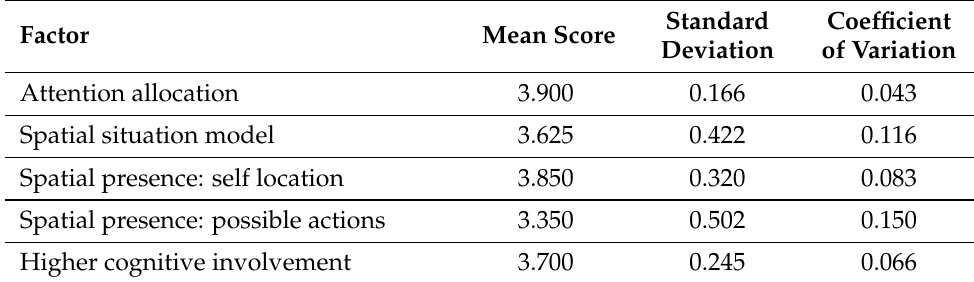
Table 2. Mean scores, standard deviations and coefficients of variation of the user experience factors.